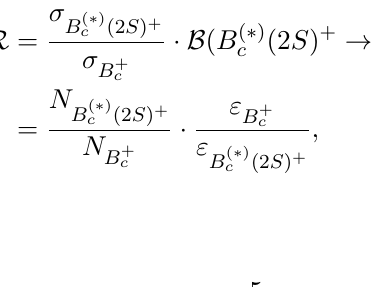
Figure 2. Mass distributions of the selected B + for the four MLP